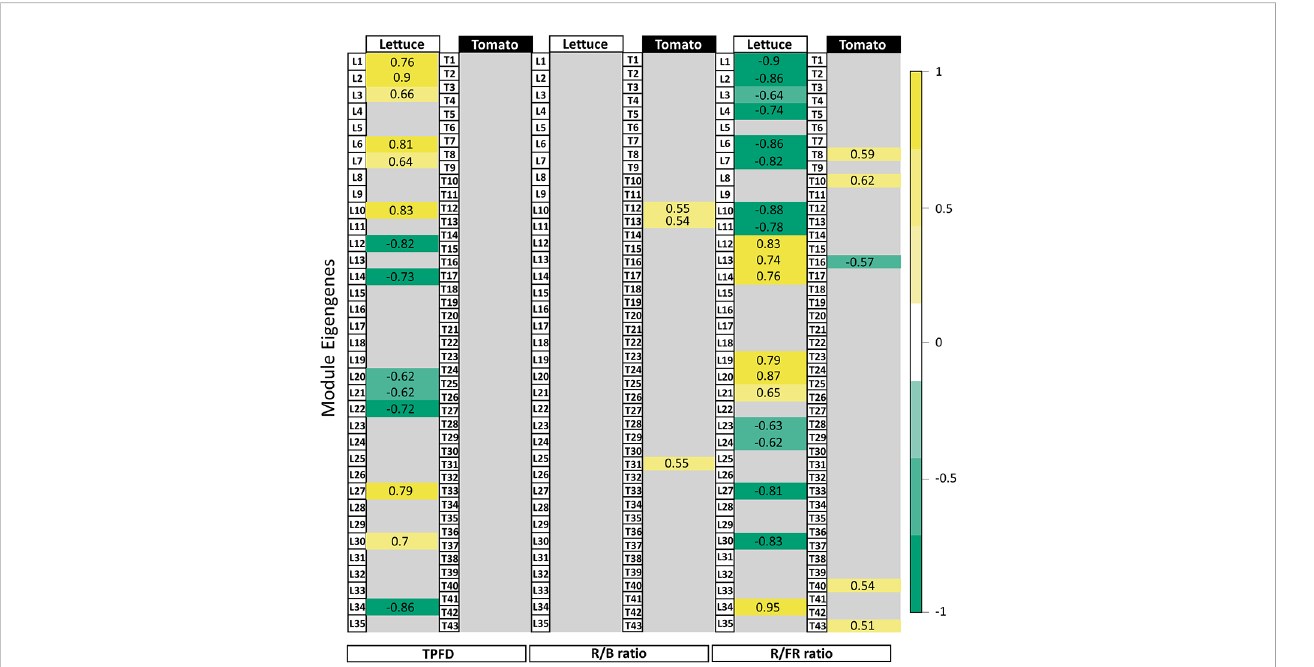
FIGURE 5 Module-trait relationships with selected light traits. Table of correlations between measured light parameters and the 35 lettuce modules and 43 tomato modules of genes identi fi ed in the network analysis. Strong positive correlations are dark yellow while strong negative correlations are dark green. Values given are the correlation coef fi cient ( r ) for each relationship. Although gene expression in lettuce varied in response to changes in TPFD, the same responses were not seen in tomato. The responses to light quality traits (i.e., R/B and R/FR ratios) were similarly variable between lettuce and tomato. Tomato gene modules correlated more strongly with the R/B ratio while the R/FR ratio had more in fl uence on gene expression in lettuce. Modules showing weak or no signi fi cant correlation with a trait were fi ltered by applying a p-value threshold (p<1e-05). See Figures S8, 11 – 13 for the complete module-trait relationships for lettuce and